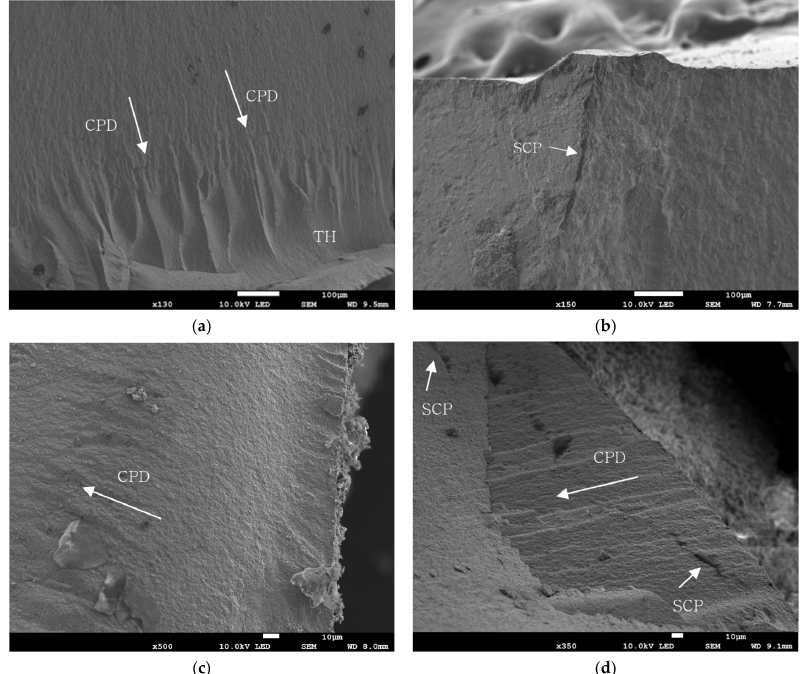
Figure 3. Representative SEM images of the fractured surface of each group: ( a ) fracture image of control group; ( b ) fracture image of group A; ( c ) fracture image of group B; ( d ) fracture image of group C. SCP: stopped crack propagation; CPD: crack propagation direction; TH: twist hackle.